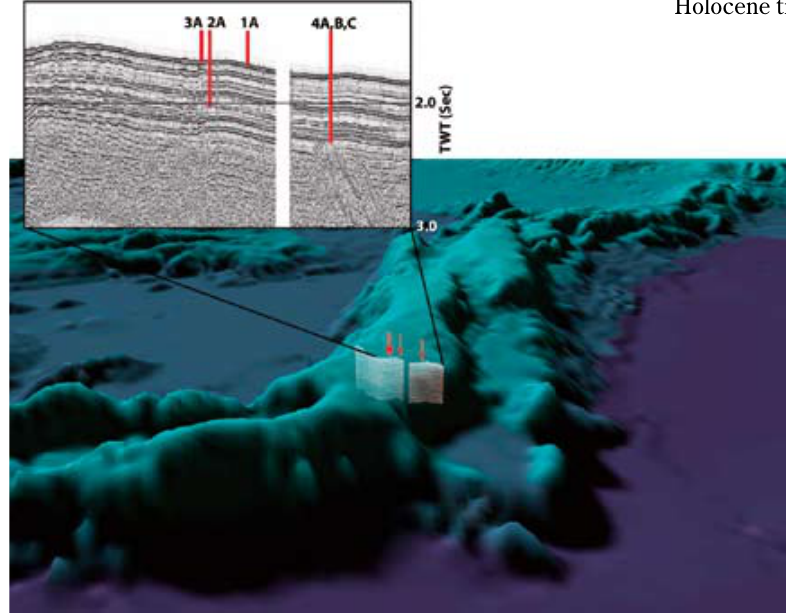
Figure 2. Bathymetry and site locations/penetration depths on reflection seismic line AWI